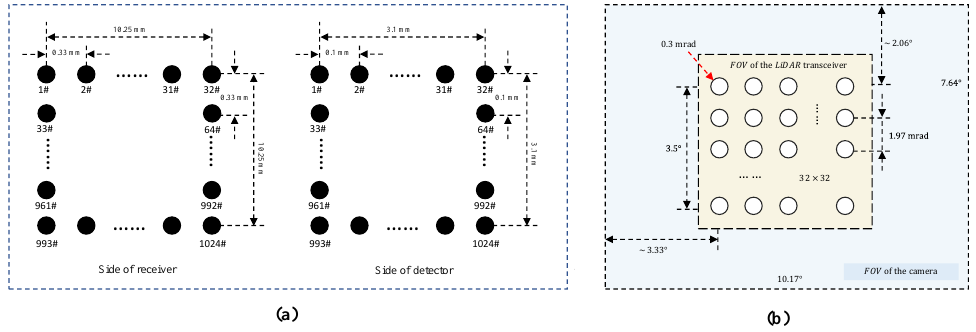
Figure 3. ( a ) Arrangement of positioning of the receiving optical fiber array at the receiver and detector ends, respectively; ( b ) schematic of the FoV relationship between the LiDAR transceiver and visible camera. The visible camera has a wider FoV than the LiDAR transceiver.